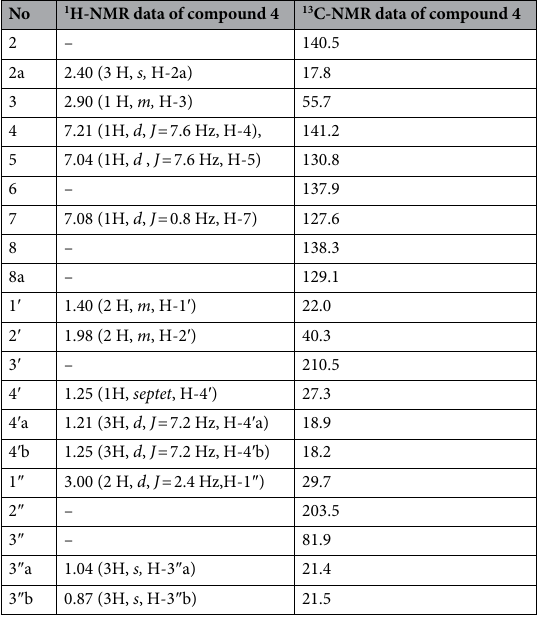
Table 2. 1 H (CDCl 3 , 400 MHz) and 13 C NMR (CDCl 3 , 100 MHz) data of compounds